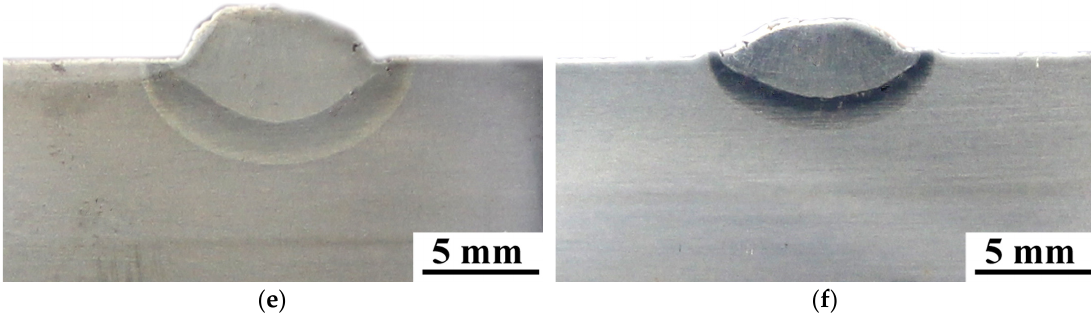
Figure 7. Results of macroscopic testing, specimen welded by: ( a ) E 38 0 R11 without coating, ( b ) liquid foil, ( c ) impregnate for concrete, ( d ) silicone spray, ( e ) paraffin wax, ( f ) underwater electrode.